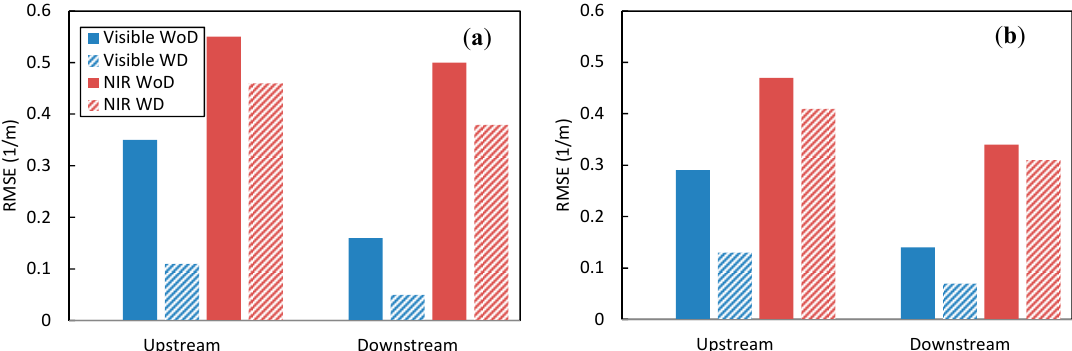
Figure 9. Performance of 𝐾 (cid:3031) retrievals expressed in terms of RMSE (1/m) using (a) 𝑅 (cid:3045)(cid:3046)(cid:3020)(cid:3036)(cid:3040)_(cid:3004)(cid:3035)(cid:3028)(cid:3041)(cid:3041)(cid:3032)(cid:3039),(cid:3024)(cid:3023)(cid:2871) and (b) 𝑅 (cid:3045)(cid:3046)(cid:3020)(cid:3036)(cid:3040)_(cid:3004)(cid:3035)(cid:3028)(cid:3041)(cid:3041)(cid:3032)(cid:3039),(cid:3008) by sampling the depths from upstream and downstream of the simulated channel with (WD) and without (WoD) accounting for deep-water reflectance 𝑅 (cid:3045)(cid:3046)(cid:2998) . We utilized the k-means algorithm to perform riverbed classification using 𝑅 (cid:3045)(cid:3046)(cid:3020)(cid:3036)(cid:3040)_(cid:3004)(cid:3035)(cid:3028)(cid:3041)(cid:3041)(cid:3032)(cid:3039) and